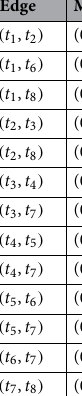
Table 2. Edge membership values of